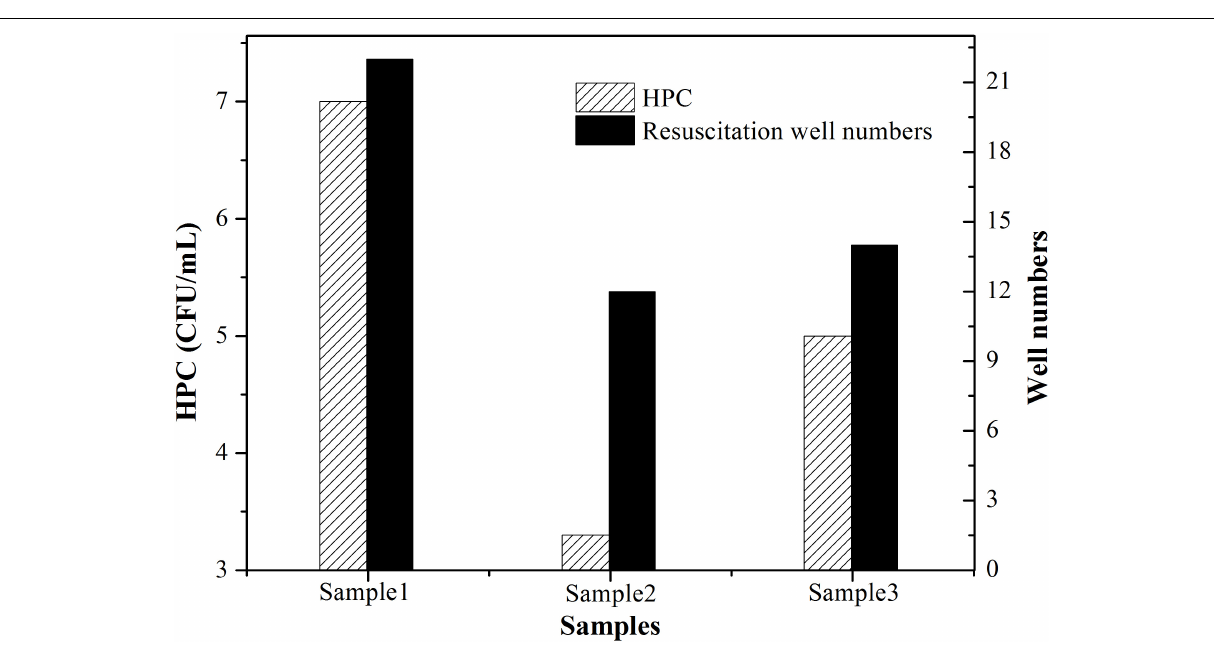
Overall, there was no significant difference between